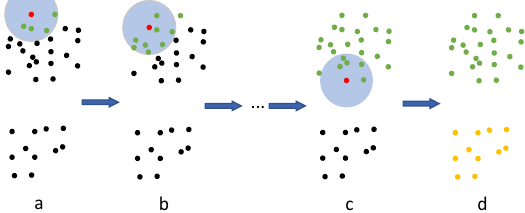
Figure 15. The process of point cloud Euclidean clustering